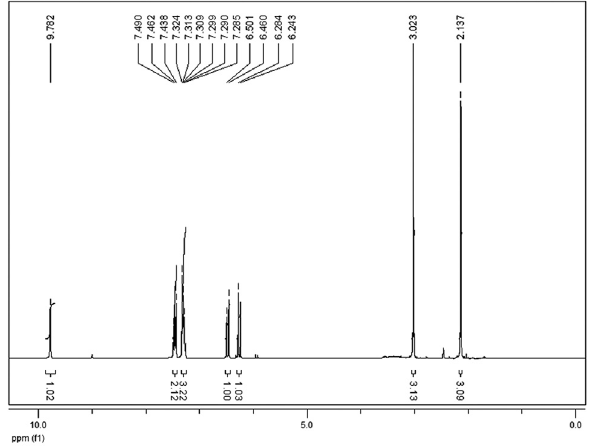
Figure 3 - 1 H RMN spectra of IR-01 in DMSO-d 6 at 300 Mhz.